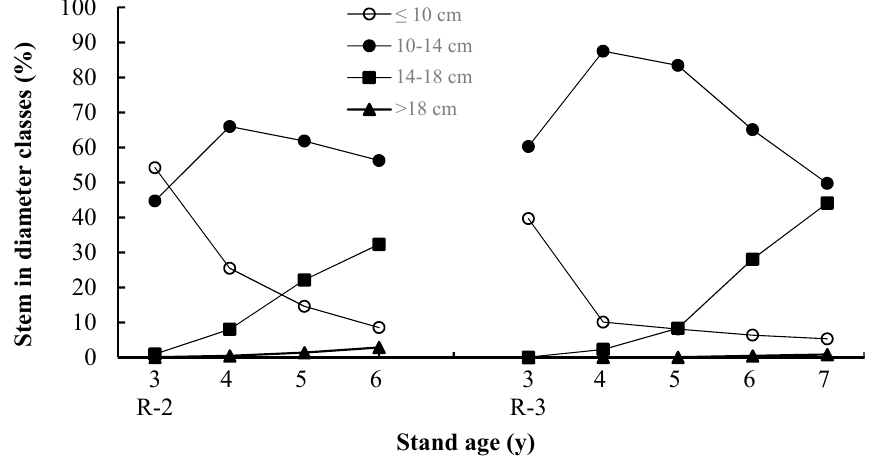
Figure 6. Changes in frequency distribution of diameter at breast height (Dbh) classes with stand age in the second and in the third rotations of A. auriciliformis . Each data point is a mean of three management treatments. Table 2. The total volumes of commercial wood produced and estimated amounts in different log classes (products) in the third rotation stand from age four to harvest.